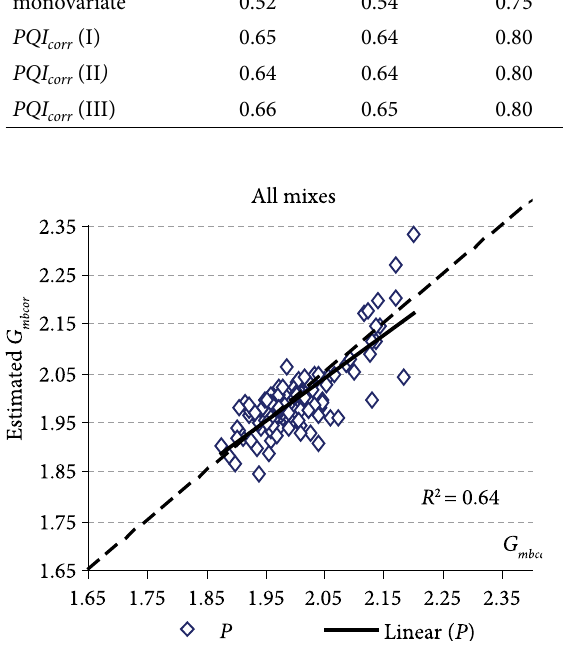
Fig. 16. Scatter plot of G mbcor estimated (multivariate correlation – model I – y -axis) vs. G